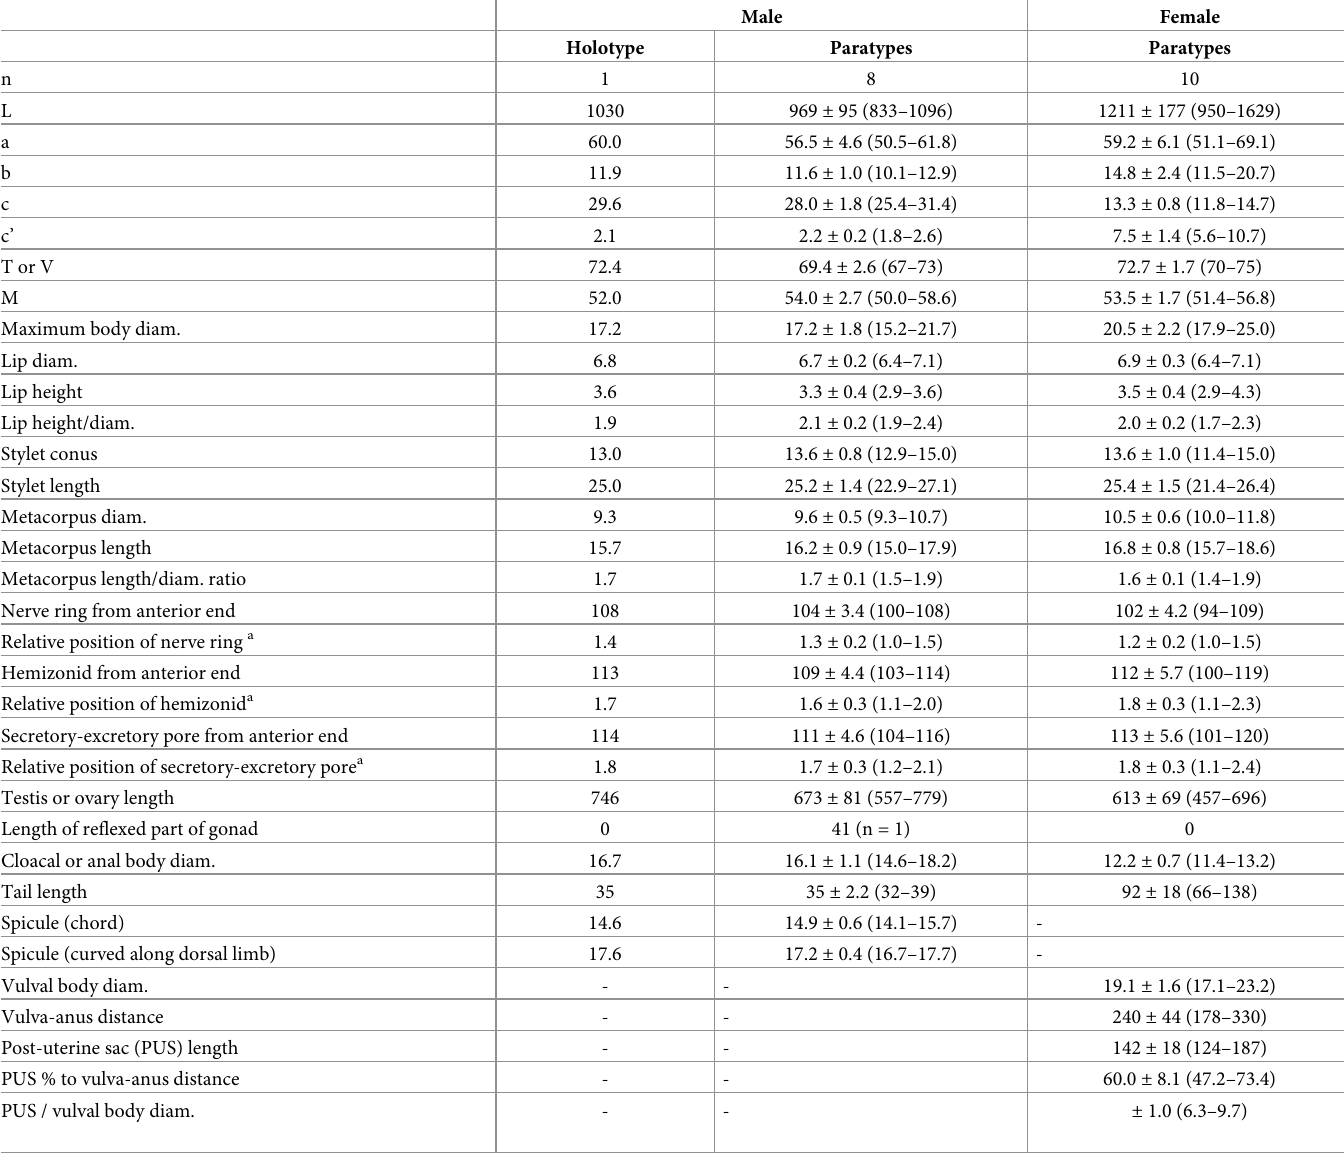
Table 1. Morphometrics of type specimens of Bursaphelenchus suri n. sp. All measurements are in μ m and in the form: mean ± standard deviation